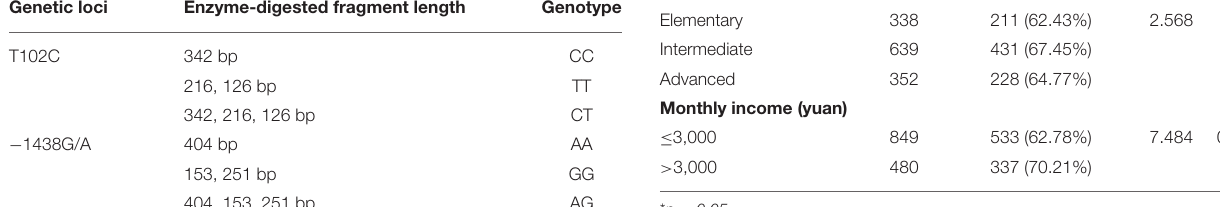
TABLE 2 | Genotype information for T102C and − 1438G/A. Genetic